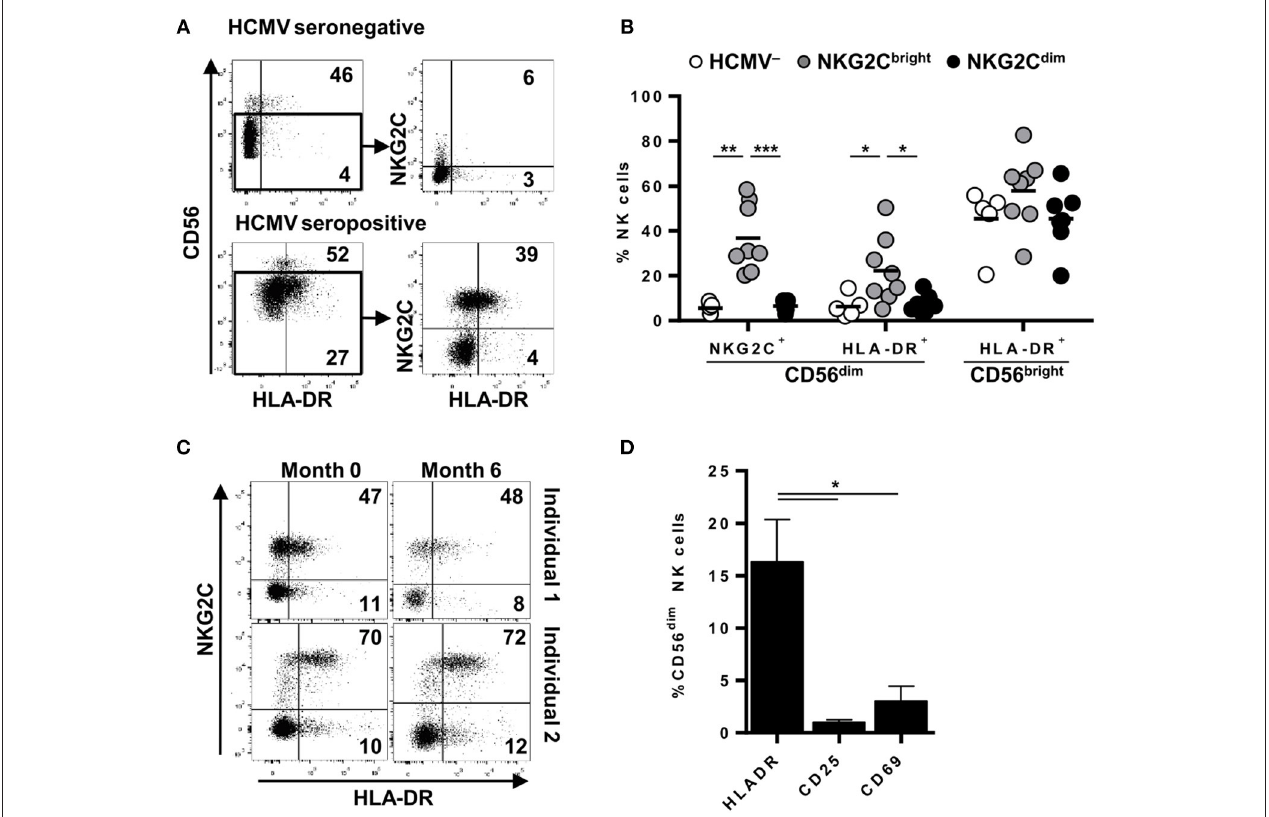
FIGURE 1 | Surface expression of HLA-DR is stably detected in variable proportions of circulating NKG2C + adaptive NK cells in the absence of activation markers. NKG2C and HLA-DR expression was analyzed by flow cytometry in circulating NK cells from seronegative ( n = 5; HCMV–) and seropositive (HCMV + ) individuals with ( n = 8; NKG2C bright ) or without ( n = 7; NKG2C dim ) NKG2C + adaptive NK cells. (A) Representative dot plots of NKG2C and HLA-DR expression in CD56 dim NK cells from HCMV- and HCMV + individuals. Inset numbers indicate proportions of HLA-DR + in CD56 bright and CD56 dim gates. (B) Percentage of NKG2C + and HLA-DR + cells in CD56 dim and CD56 bright NK cell subsets in individuals categorized according to their HCMV serology and the presence (NKG2C bright ) or absence (NKG2C dim ) of NKG2C + adaptive NK cells. (C) Dot plots showing NKG2C and HLA-DR phenotype along time in two out of five HCMV + individuals analyzed. Inset numbers indicate frequencies of HLA-DR + cells in NKG2C + and NKG2C- NK cells. (D) HLA-DR, CD25, and CD69 expression on circulating CD56 dim NK cells from HCMV + individuals with NKG2C + adaptive NK cells (mean ± SEM, n = 6) (* p < 0.05, ** p < 0.01, *** p < 0.001).